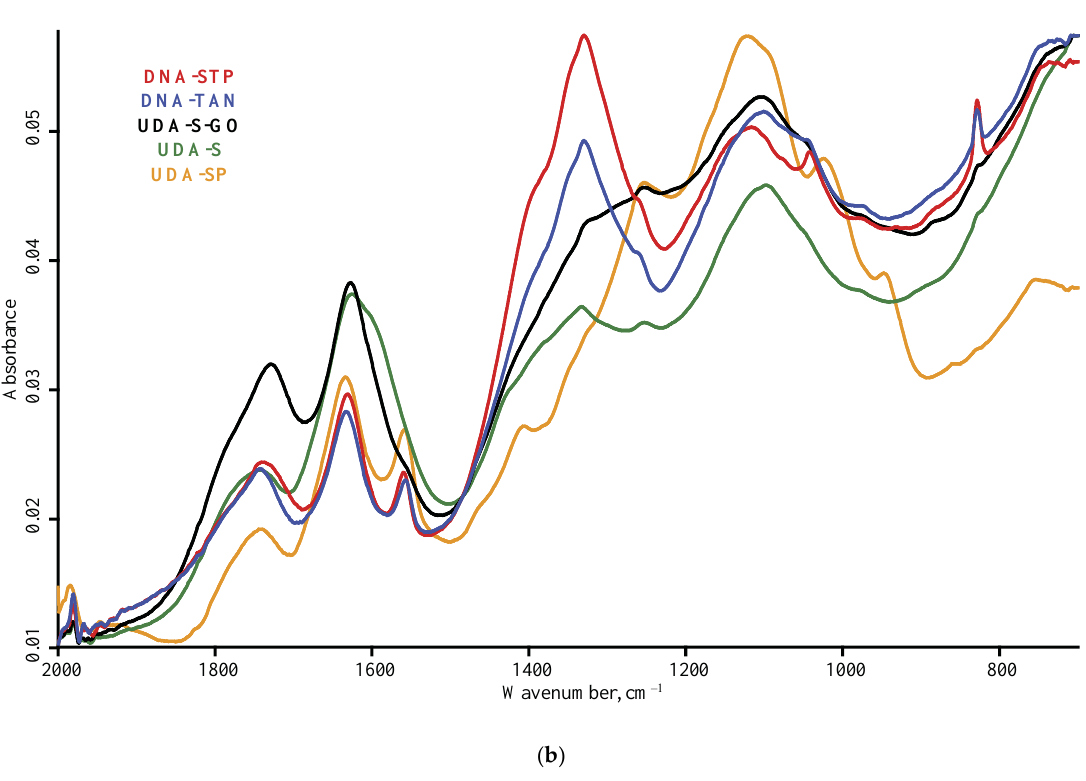
Figure 4. ATR mode, LN-MCT photovoltaic detector; nanodiamond brands: red, DNA-STP; blue, DNA-TAN; black, UDA-S-GO; green, UDA-S; orange, UDA-SP; ( a ) 4000–2500 cm − 1 , ( b ) 2000–400 cm − 1 range. Spectra were smoothed (13 points) and normalized to maximize each spectrum.